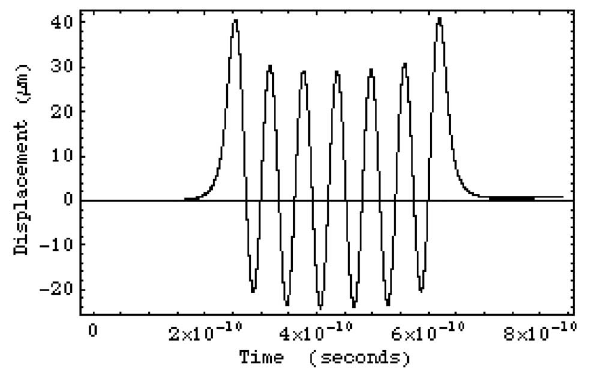
FIG. 2. Numerical trajectory calculation for six periods of VISA undulator, with symmetric two-half-block termination. The wiggle amplitude, peak to peak, is about half the beam diameter.